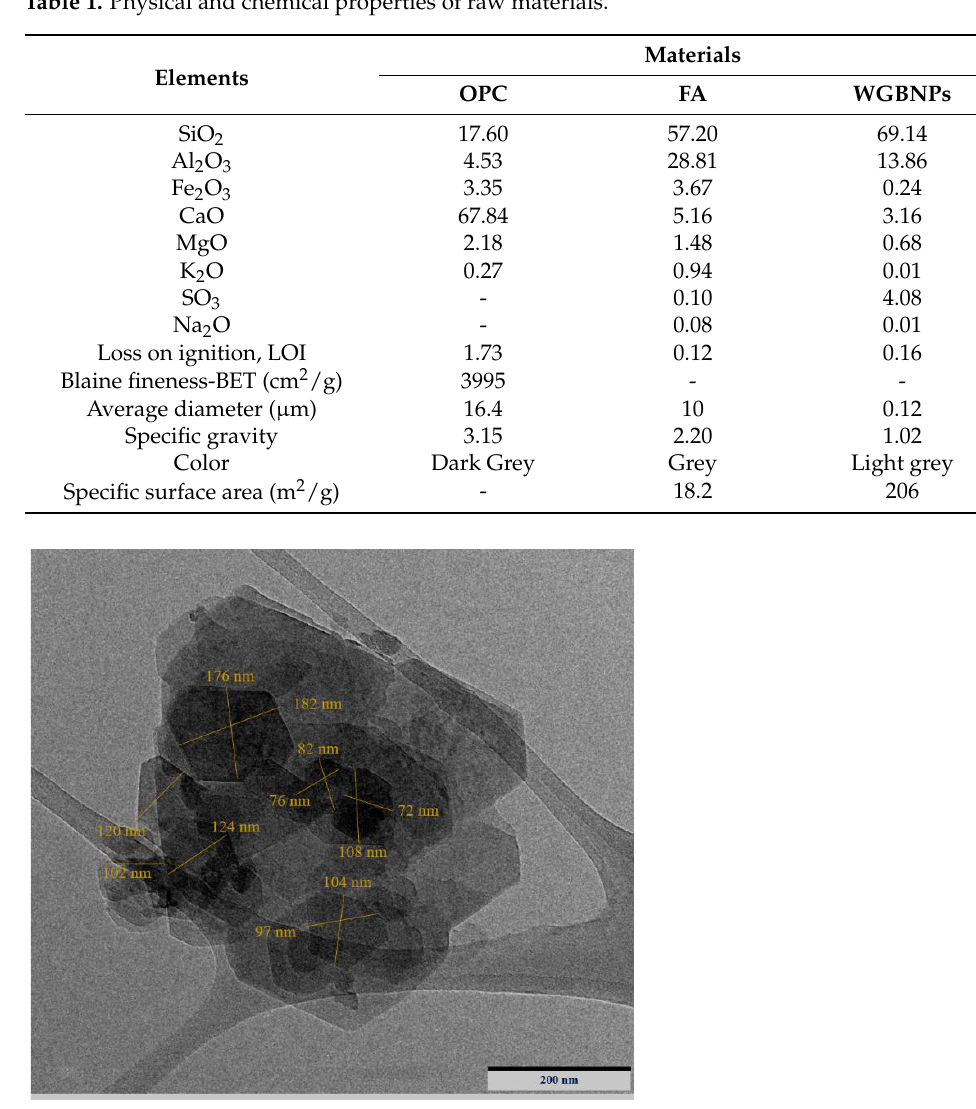
Figure 2. TEM image of WGBNPs.